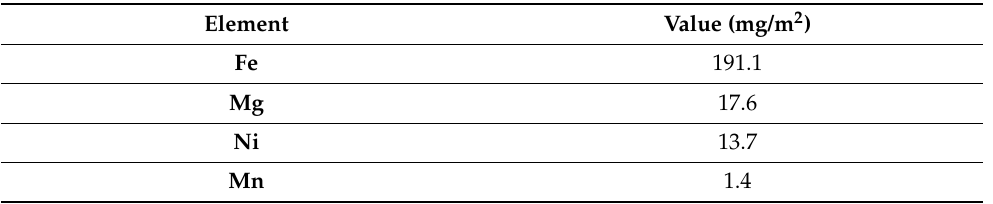
Table 3. The feed spacer and membrane surface coupon major elemental composition from the membrane